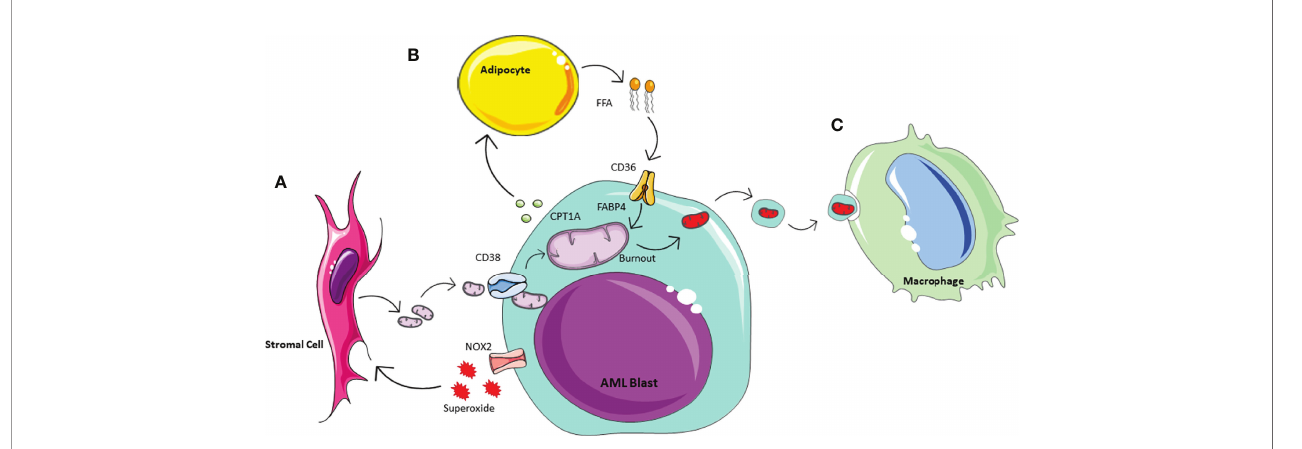
FIGURE 2 | Schematic of AML metabolic of bone marrow microenvironment. Acute Myeliod Leukaemia (AML) is able to manipulate the surrounding environment to enhance its own metabolism. (A) In response to the increase energy demanding, AML produces NOX2 derived superoxide, whichacts on BM stormal cells to activate mitochondrial transfer. Mitochondrial uptake by AML is enable through tunneleing nanotubules by the transmembrane glycoprotien CD38. (B) AML manipulates adipocytes inducing phosphorylation of lipase, to activate lipolysis and te release of Free Fatty Acids (FFA). AML is able to icrease FFa uptake via increased expression of CD38 and fatty-acid binding protiens (FABPs). (C) To prevent the activation of apoptotic pathways, AML outsources its waste mitochondria. This process of outsourcing mitophagy utilises the macrophages in the